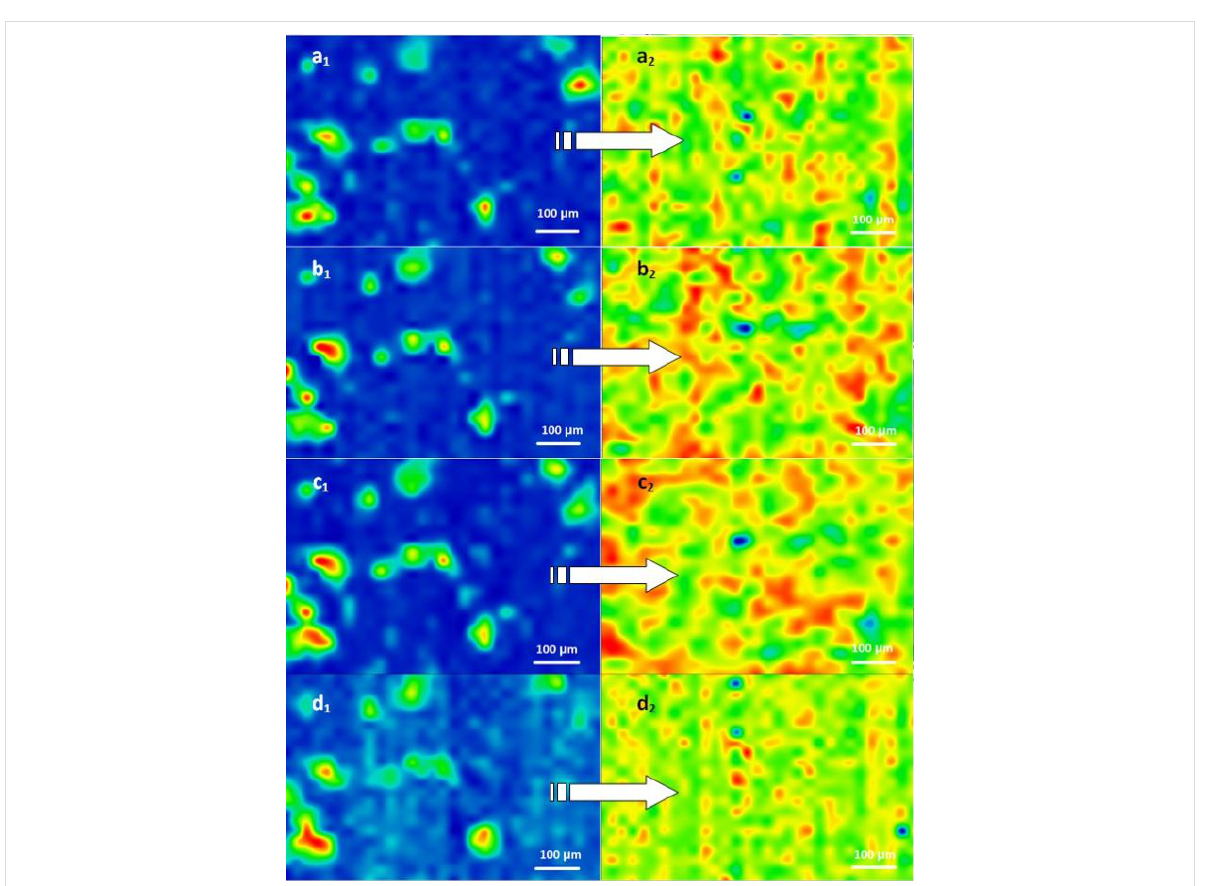
Figure 3: Second derivate IR mappings of the drop cast surface (1) and the thin coating ( F = 300 mJ/cm 2 ) surfaces (2). Intensity distributions are (a) 2954 cm − 1 (CH 3 stretch), (b) 1739 cm − 1 (C=O carbonyl group), (c) 1450 cm − 1 (assigned to the lactides –CH 3 group), and (d) ≈ 1182 cm − 1 (–C–O– bond